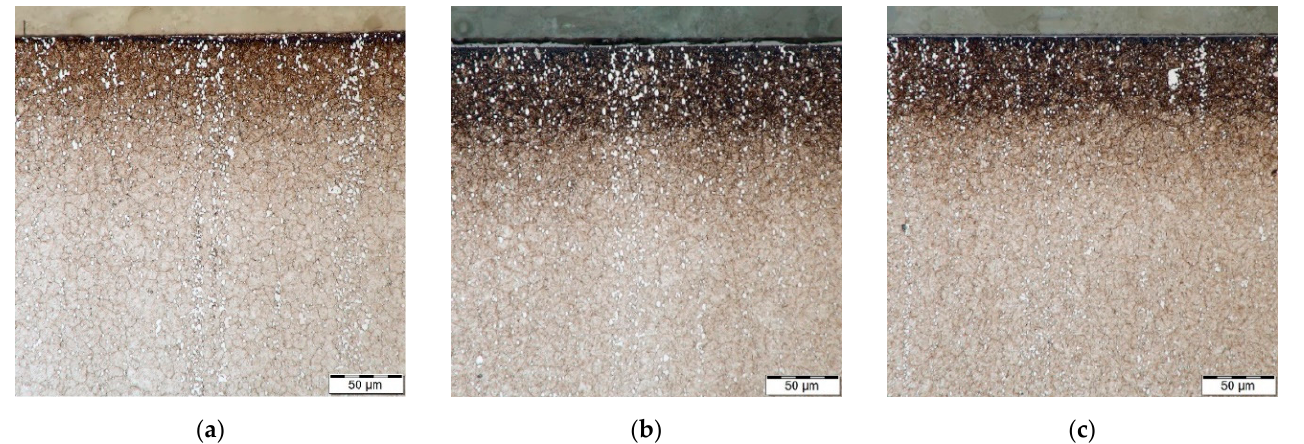
Figure 3. Microstructure optically observed with magnification 1000× on the steel H13 samples cross sections: ( a ) PN ma- terial; ( b ) PN/AlCrBN material; ( c ) PN/AlCrVN material.